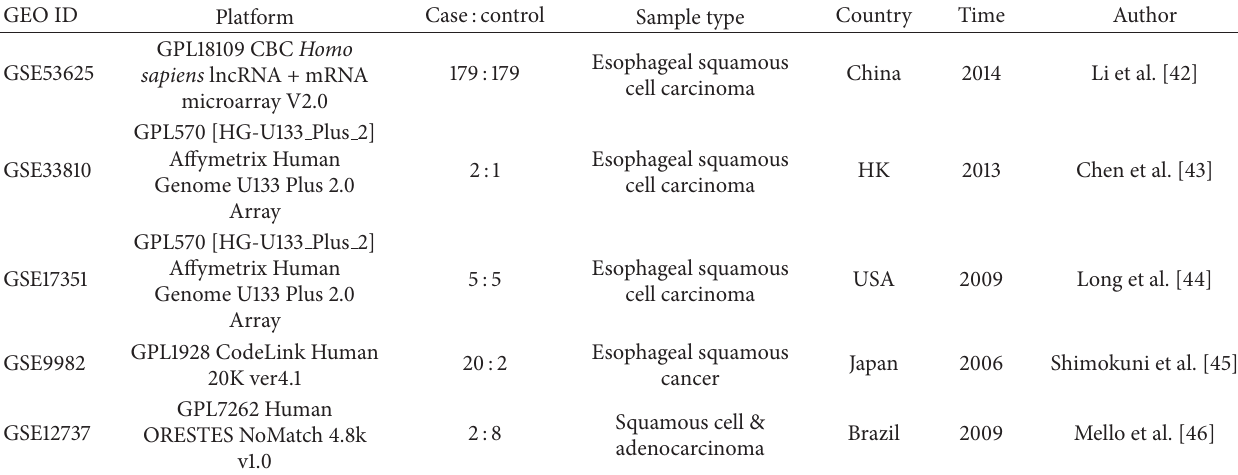
Table 1: The information of gene expression microarrays of EC.